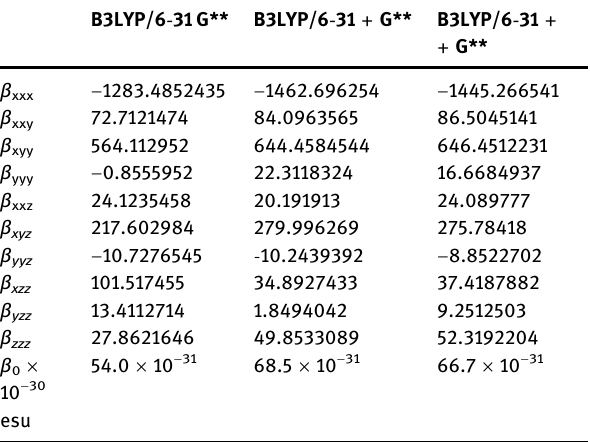
Table 2: Calculated values of hyperpolarizability by